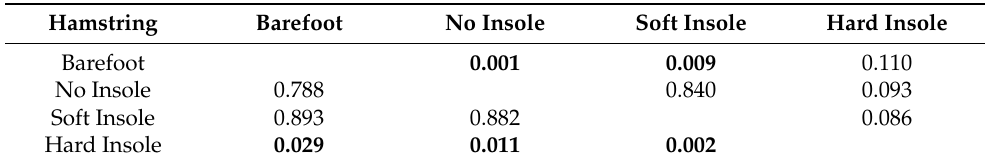
Table 3. EMG for hamstring at speed 4 according to support. Pairwise comparisons (upper diagonal, amputees; lower diagonal, controls).